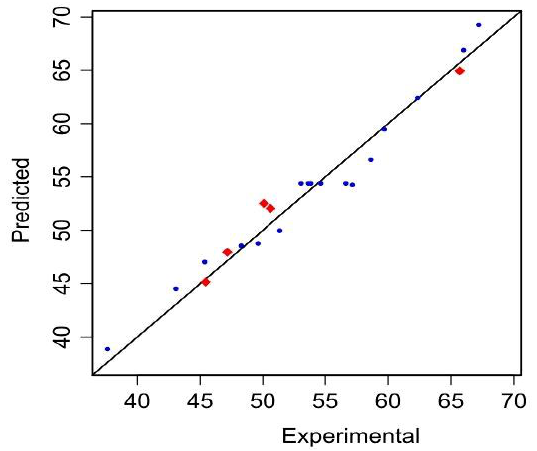
Figure 2. Scatter diagram of Ni(II) removal e ffi